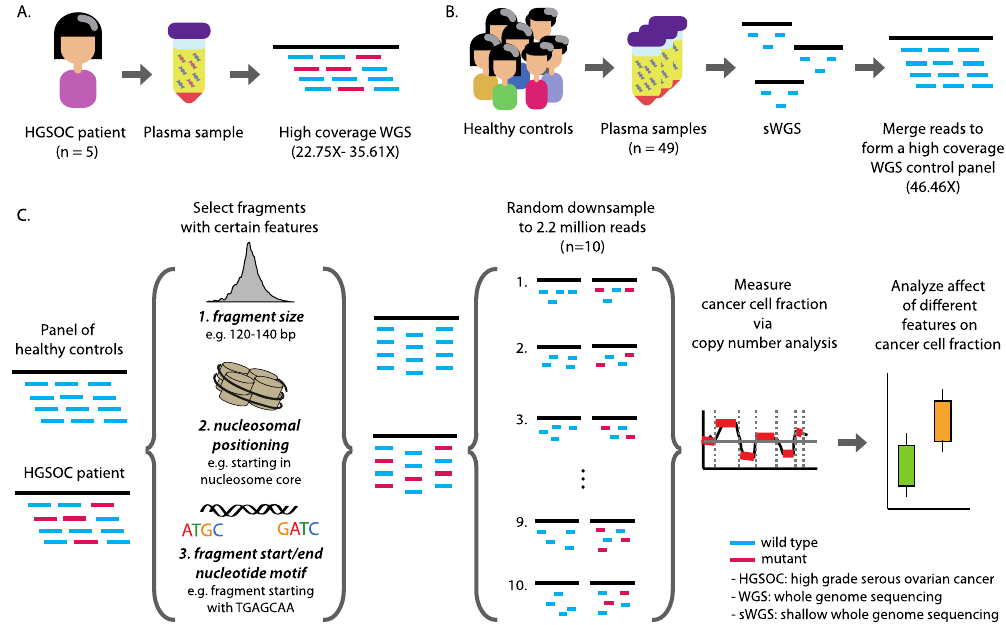
Figure 1. ( A ) In this study we performed paired-end high coverage whole genome sequencing on plasma samples from 5 high grade serous ovarian cancer patients and ( B ) paired-end shallow whole genome sequencing (sWGS) on 49 healthy plasma controls. We created a control panel by merging reads across all healthy samples ( C ) Three features were calculated for each plasma DNA fragment: fragment size, relative position of fragment start and end sites with respect to the closest nucleosome dyad, and a nucleotide frequency score based on the 10 bp region spanning either side of fragment start and end. For both the control panel and the patient high-coverage datasets, fragments were selected based on these features and repeated random down-sampling was carried out in order to create 10 technical replicates (0.1 × coverage, 2.2 million reads each). These shallow whole-genome datasets underwent copy number analysis and the cancer-cell fraction (CCF) was calculated using ichorCNA. This allowed us to determine features that are enriched in circulating tumor DNA versus circulating cell-free